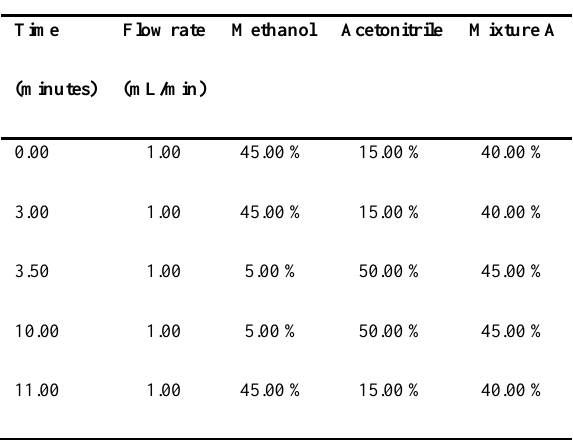
Table 3. Two different gradient systems (A &